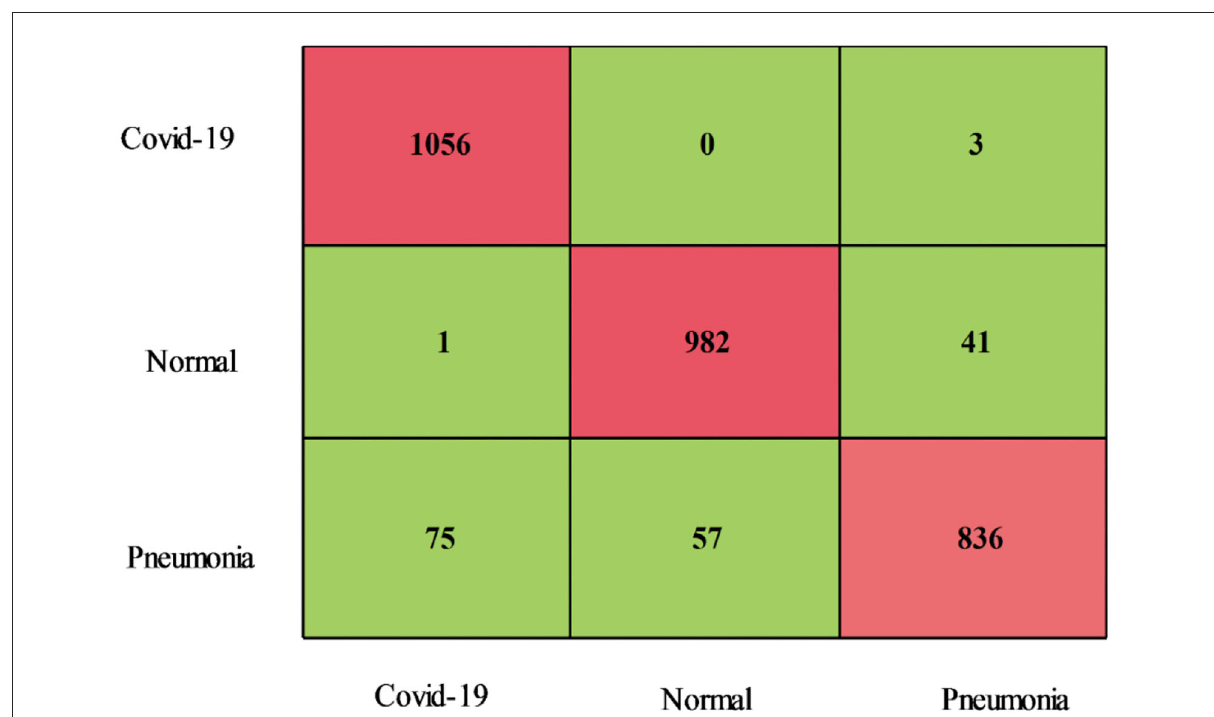
FIGURE10 Confusion matrix of COVID-GAN and COVID-Net mini chest X-ray dataset after